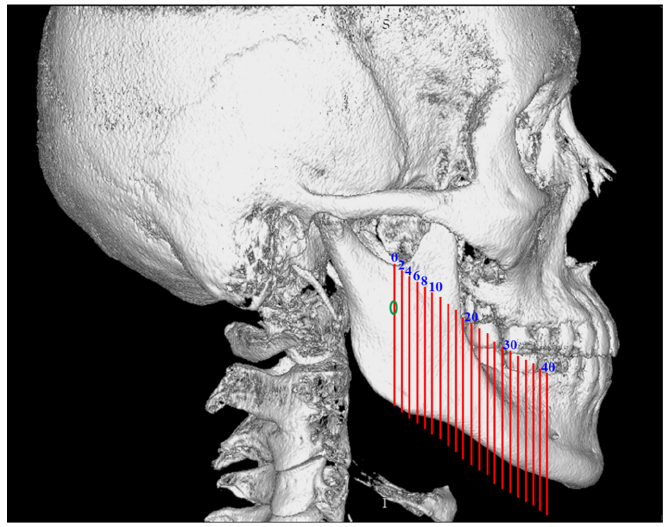
Figure 1. Green circle: mandibular canal (base slice: 0 mm); twenty-one vertical slices (red lines) from 0 mm forward to 40 mm. J. Clin. Med. 2021 , 10 , x FOR PEER REVIEW